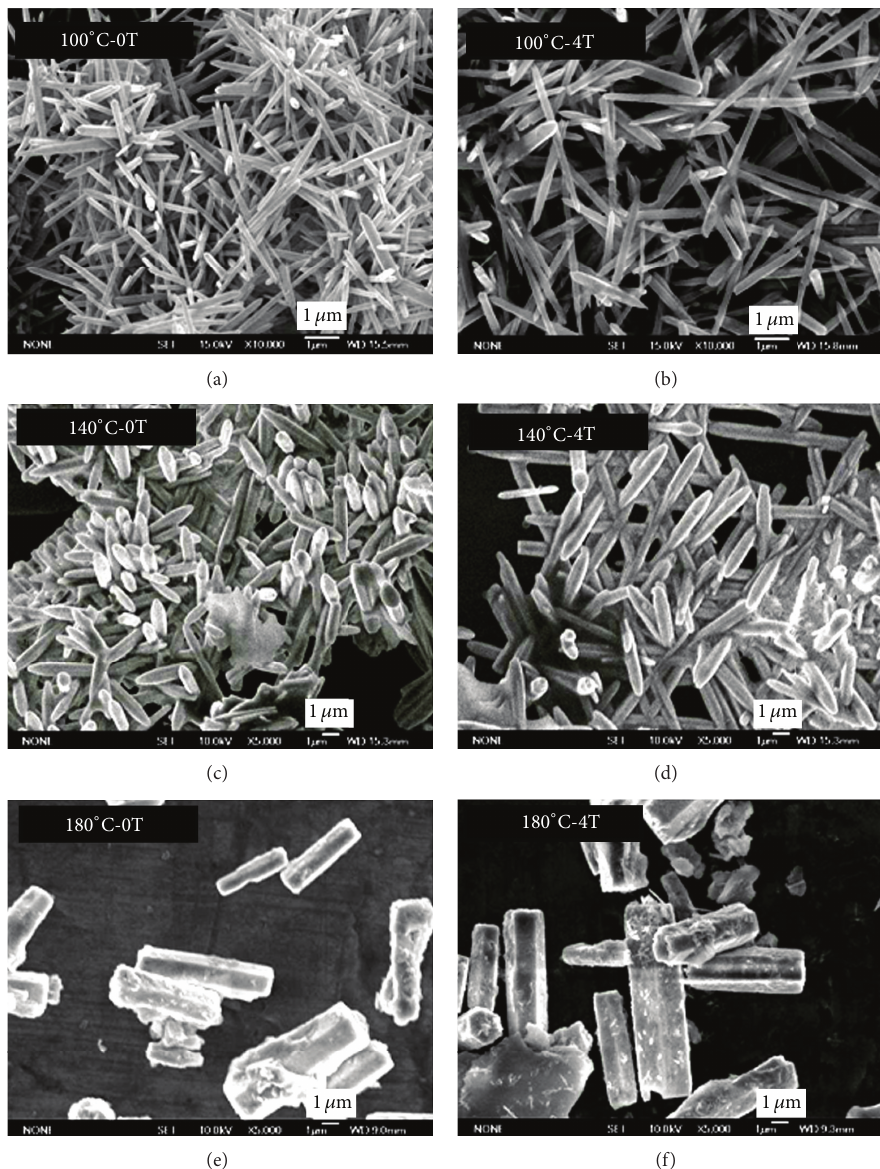
Figure 3: The SEM images of the samples: (a) 100 ∘ C-0T, (b) 100 ∘ C-4T, (c) 140 ∘ C-0T, (d) 140 ∘ C-4T, (e) 180 ∘ C-0T, and (f) 180 ∘ C-4T.